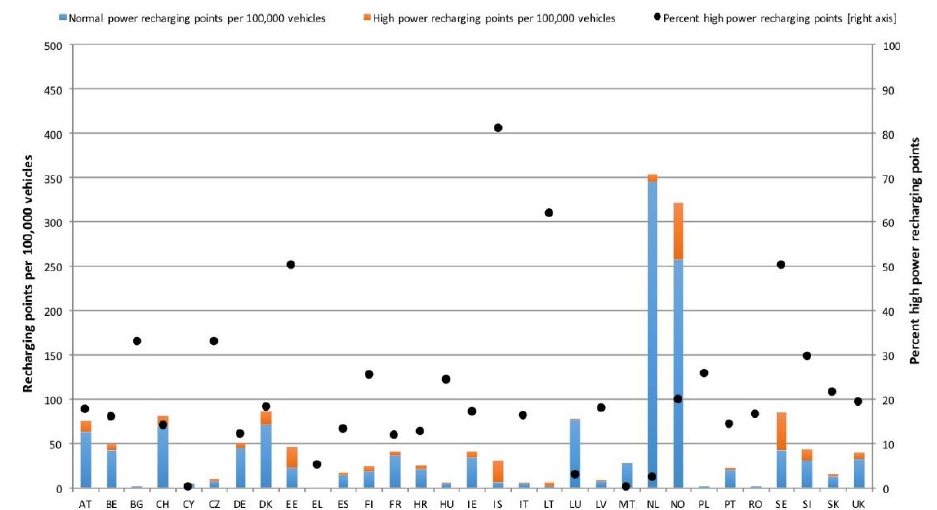
Figure 2. Status of publicly accessible recharging points per 100,000 vehicles across Europe (2017) (own elaboration on data from [57]).